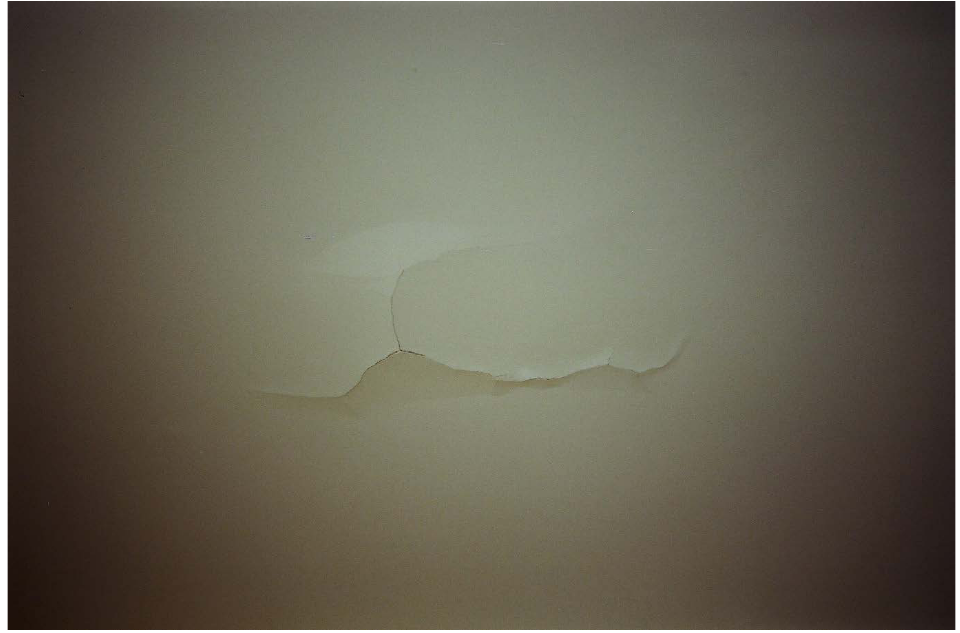
Figure 1 : crack, schism, rip(ping), cutting together